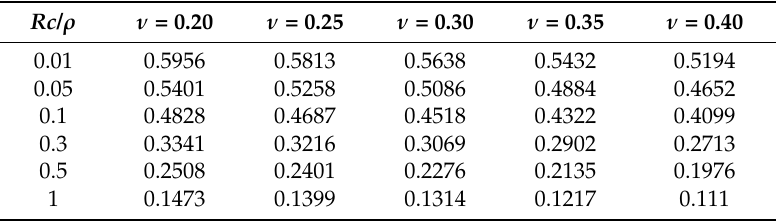
Table 2. Values of H for U-shaped notches (2 α = 0) Reproduced with permission from Berto, F.; Lazzarin, P. Mater. Sci. Eng.: R Published by Elsevier, 2014 [16]. Rc / ρ ν =